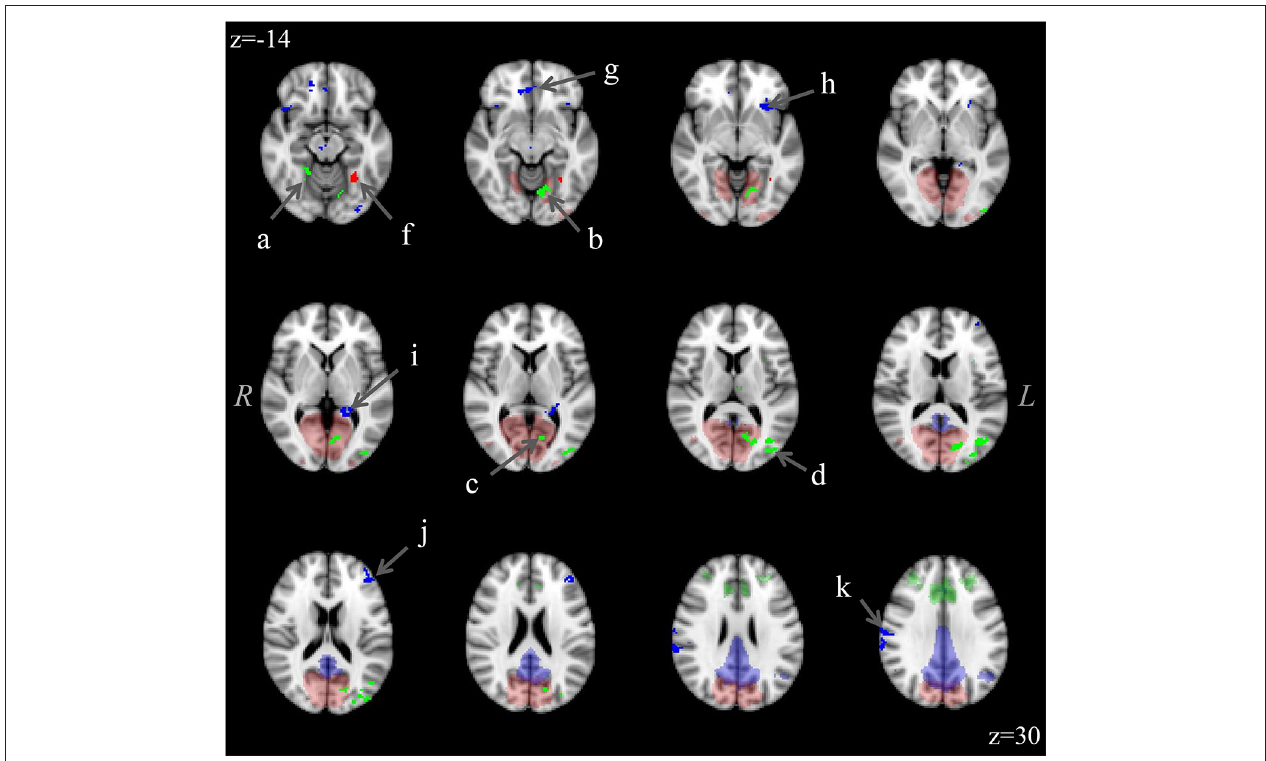
shown); the visual network cluster was located in (f) left fusiform gyrus; and the default mode network clusters were located in: (g) right medial frontal gyrus, (h) left inferior frontal gyrus, (i) left parahippocampal gyrus, (j) left middle frontal gyrus; and (k) right postcentral gyrus. T-maps were thresholded to a voxel-wise p < 0.005 and clustered to ensure a family-wise p < 0.05. The control group showed no regions of greater connectivity. Images are overlaid on the MNI152 brain and are presented in radiological orientation (right is left).